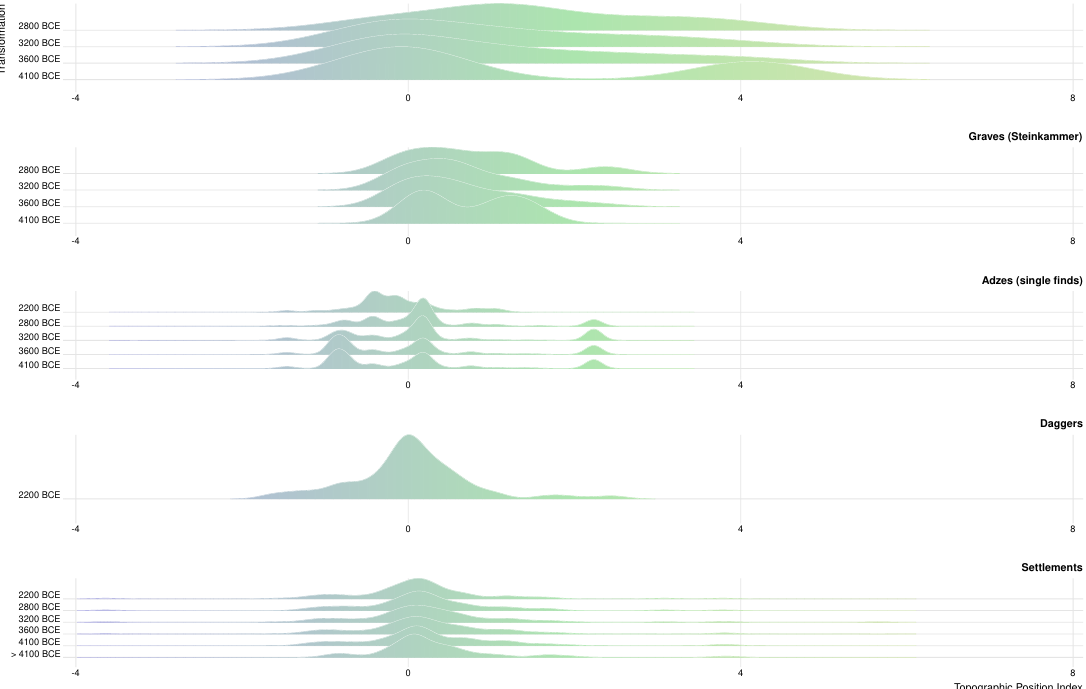
Figure 7. The occurrence of archaeological sites in relation to topographic location during Neolithic phases. Settlement characteristics did not change during the Neolithic era and showed a preference for flat locations. Graves and stone adzes had a more heterogeneous pattern of distribution, with a focus on flat and slightly exposed